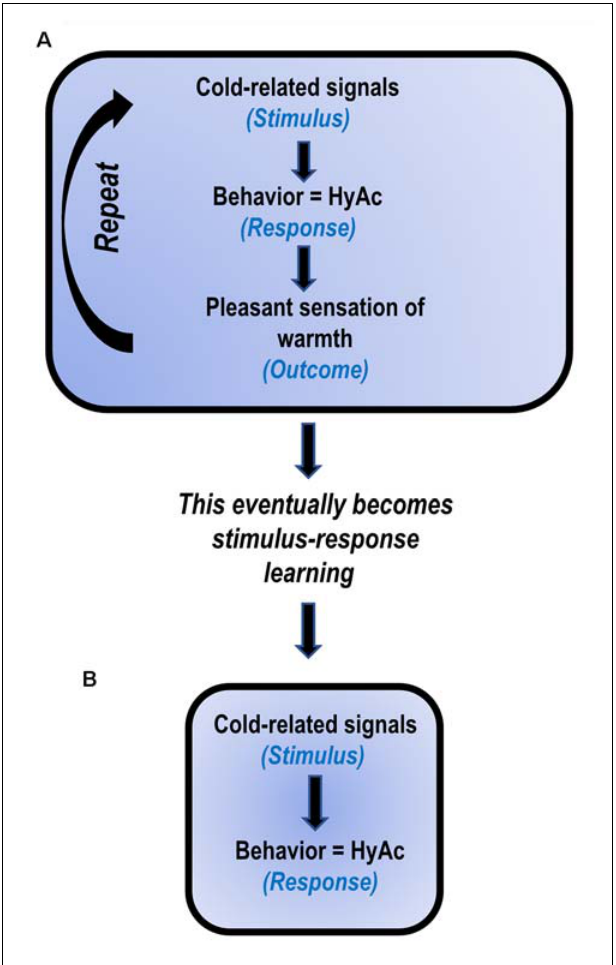
FIGURE 2 | Proposed model: HyperActivity (HyAc) a developed habit (based on Uniacke et al., 2018). (A) In the early stages, HyAc involves stimulus-response-outcome learning. (B) After daily repetition for extended periods, the behavior becomes less sensitive to the outcome and